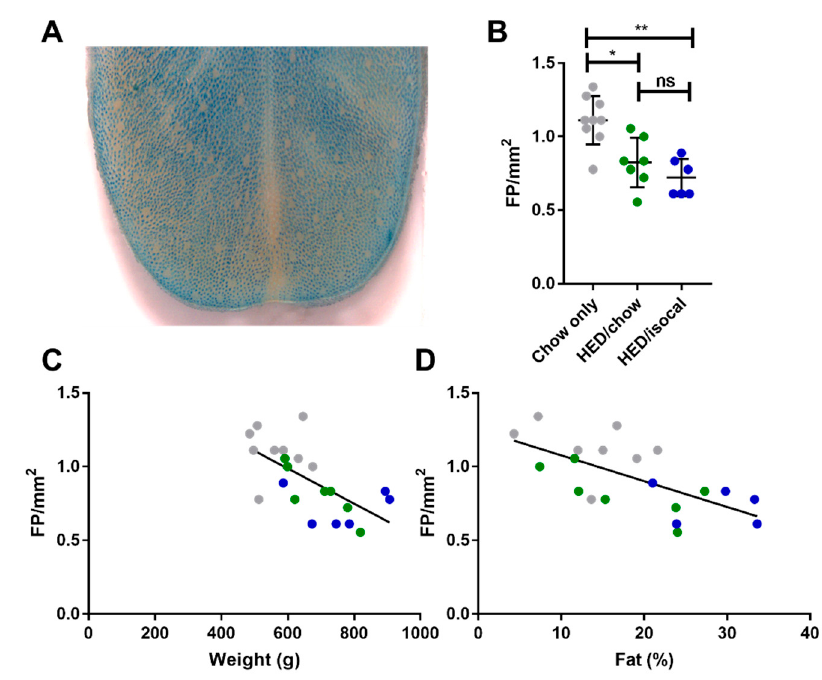
Figure 2. ( A ) Representative image of anterior tongue, with fungiform papillae the pink regions not taking up methyl blue dye. ( B ) Fungiform Papillae (FP) density in rats consuming chow-only (grey, n = 9), high-energy diet (HED) then chow (green, n = 7), and HED then HED isocaloric (blue, n = 6). ( C ) Fungiform papillae (FP) per mm2 (y-axis) versus Weight (g) (x-axis). Chow-only (grey, n = 9), HED then chow (green, n = 7), and HED then HED isocaloric (blue, n = 6). Pearson’s r = − 0.646, p = 0.0012. ( D ) Fungiform papillae (FP) per mm2 (y-axis) versus Body Fat (%) analyzed by DXA scan (x-axis). Chow-only (grey, n = 9), HED then chow (green, n = 7), and HED then HED isocaloric (blue, n = 6). Pearson’s r = − 0.655, p = 0.002. ns denotes non significant; * denotes p < 0.05; ** denotes p < 0.01.